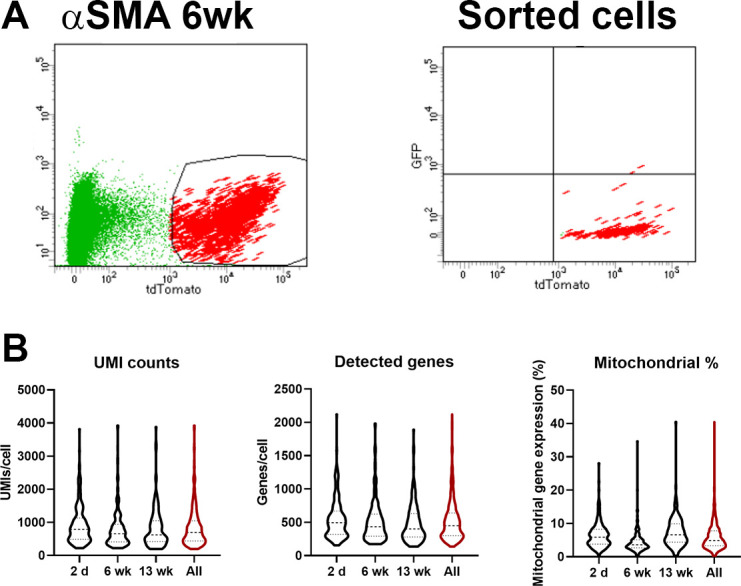
Quality control data for single-cell RNAseq dataset.(A) Gating for cell sorting of the 6-week chase cells. (B) Violin plots showing summary data for unique molecular identifier (UMI) counts, number of genes detected, and proportion of mitochondrial transcripts within the dataset.